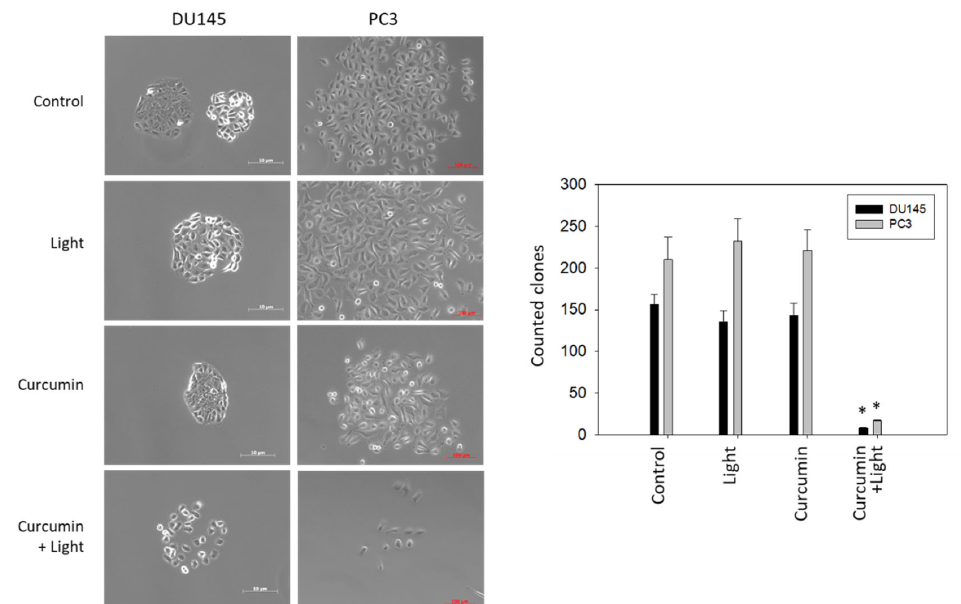
Figure 2. Left panel: Morphologic alterations of DU145 and PC3 clones after curcumin (0.2 μ g/mL), visible light (5 min at 1.65 J/cm 2 ) or curcumin, and light exposure. Controls remained untreated. Pictures were taken after 7 days of incubation. Right panel: Influence of visible light (5 min at 1.65 J/cm 2 ), curcumin (0.2 μ g/mL), or curcumin–light combination on clonogenic growth, compared to untreated controls. Error bars indicate standard deviation; * indicates significant difference to untreated controls. n = 3.